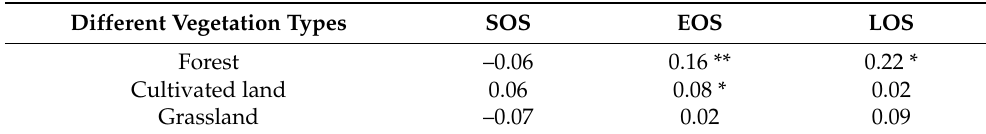
Table 4. Trends of change in vegetation phenological parameters in three vegetation types of northeast China for 1982–2014.